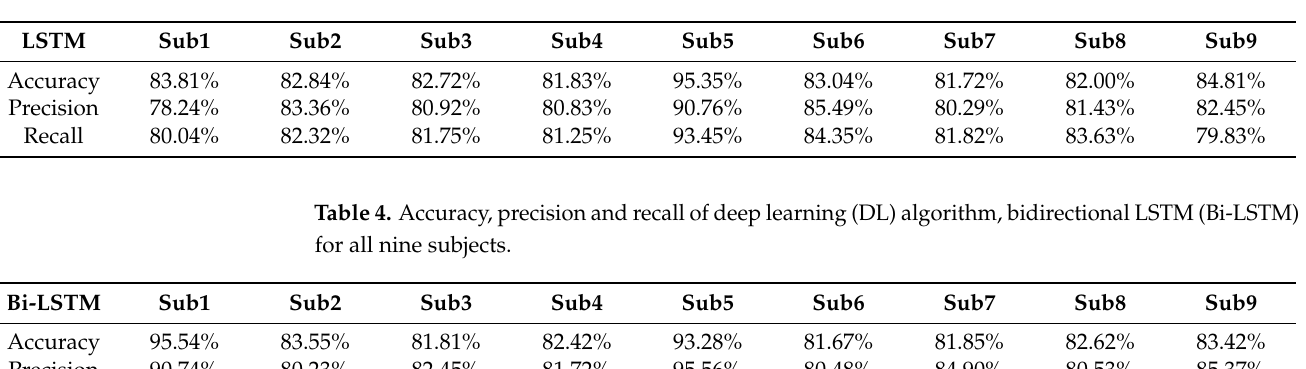
Table 3. Accuracy, precision and recall of deep learning (DL) algorithm, long short-term memory (LSTM) for all nine subjects.